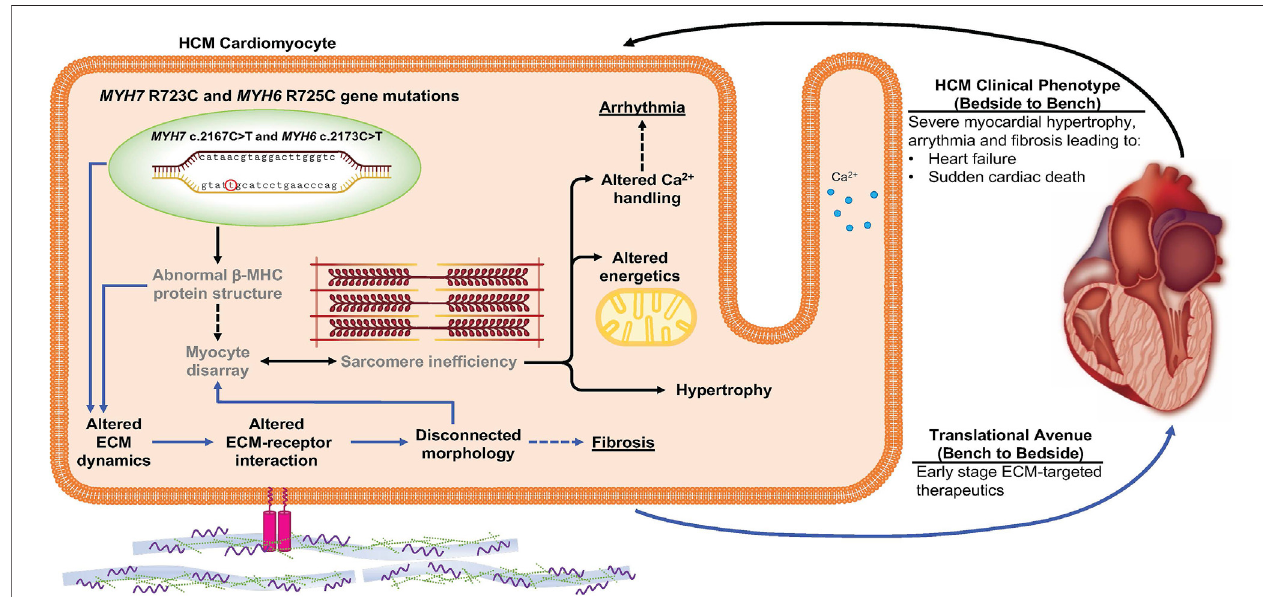
FIGURE 7 | Schematic depicting the impact of MYH7/MYH6 mutation in mediating hypertrophic cardiomyopathy. Our data indicate that MYH7/MYH6 mutation results in hypertrophy, dysregulation of metabolic as well as ECM dynamics. Solid black arrows and bold text represent HCM phenotypes that have been reported for other MYH7 mutations,greytextrepresentspreviouslyreportedfeaturesof MYH7 mutations.SolidbluearrowsrepresentthemutationassociatedECMdynamicswhich is novel to the fi eld and could provide targets to develop drug therapies potent in the early stages of HCM.